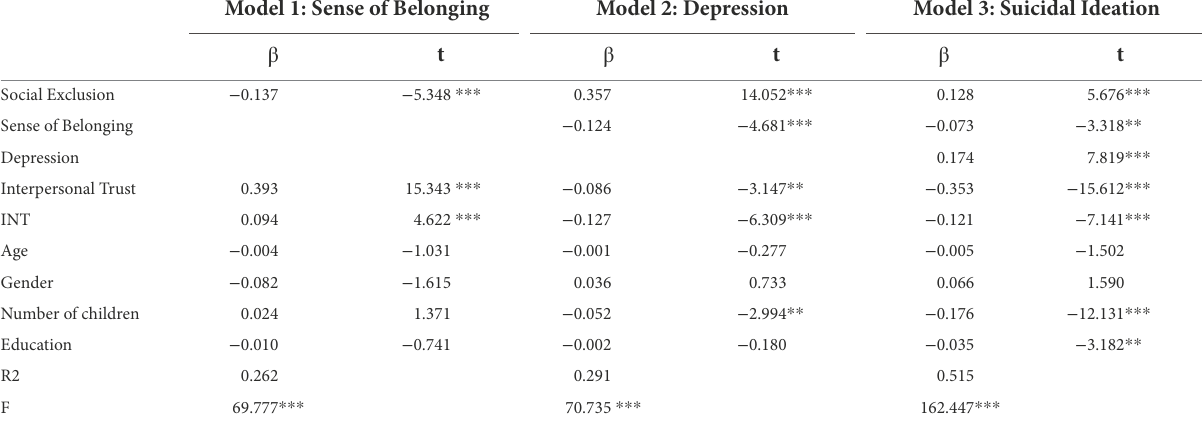
TABLE 4 Testing moderation effect of interpersonal trust.